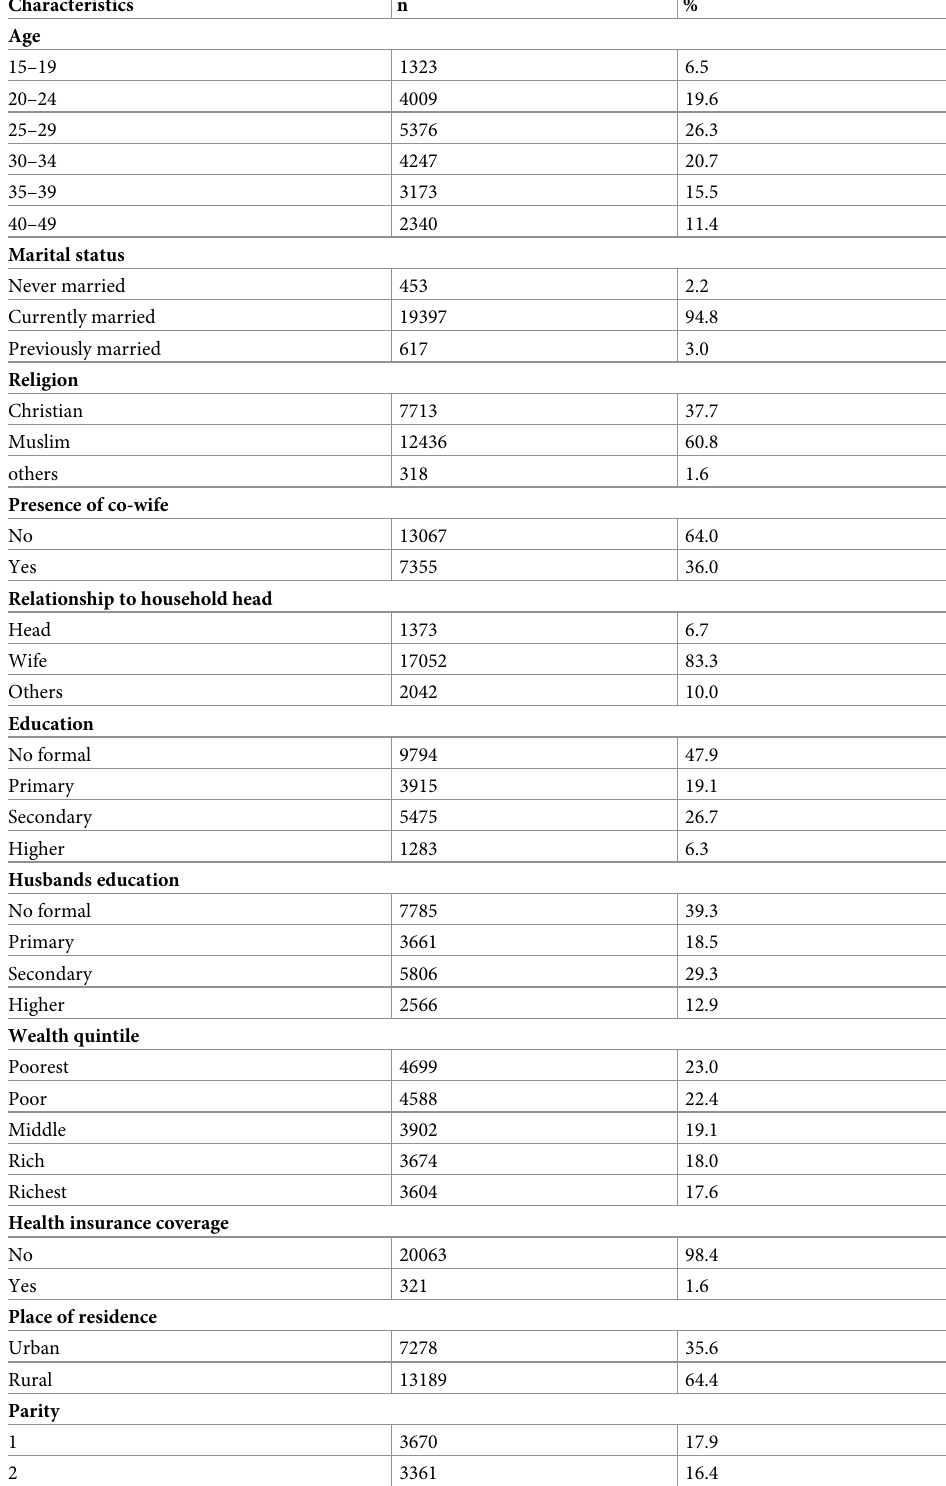
Table 1. Weighted distribution of women by socio-demographic, maternal and obstetric